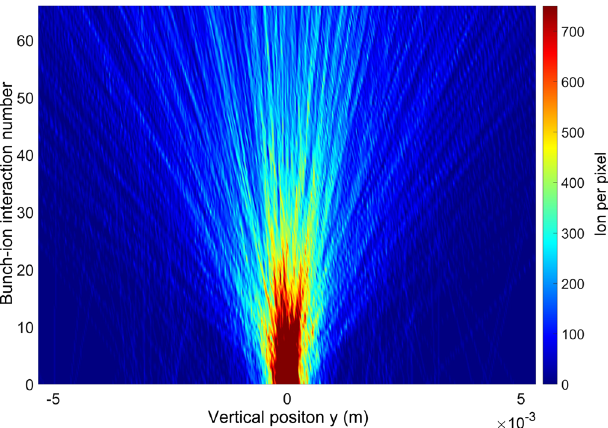
FIG. 7. Tracking of a CO þ ion cloud during the clearing gap. The ion vertical distribution is plotted vs time (expressed in number of bunch-ion interactions) and the vertical position y. The beam-ion interaction is switched off but the effect of magnets and clearing electrodes is present. Number of ions at the start of the simulation N i 0 ¼ 35